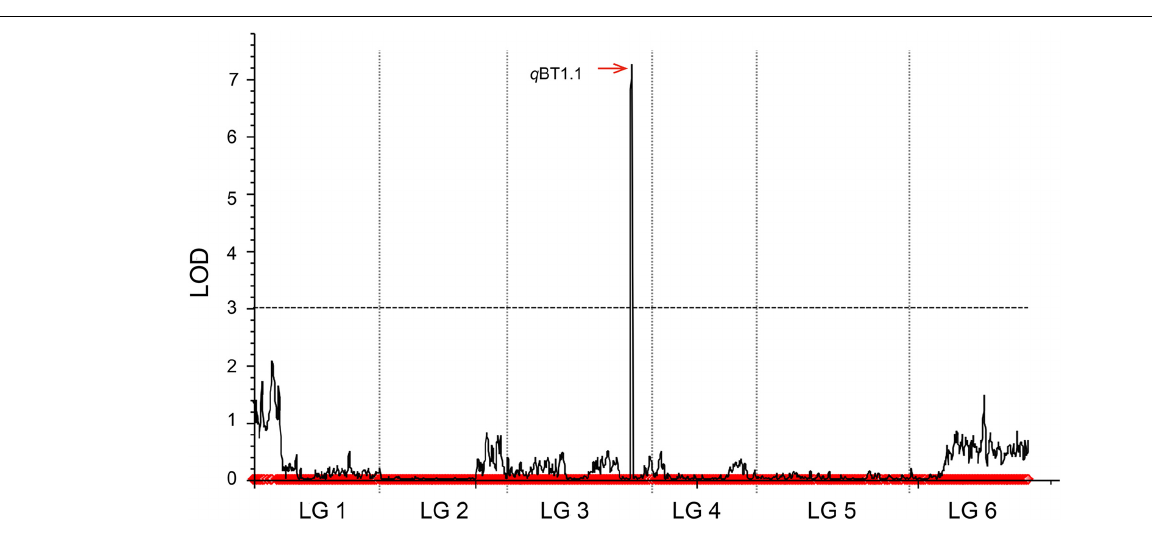
FIGURE 2 | Mapping QTLs controlling spinach bolting trait using a high-density genetic linkage map constructed with SLAF markers.